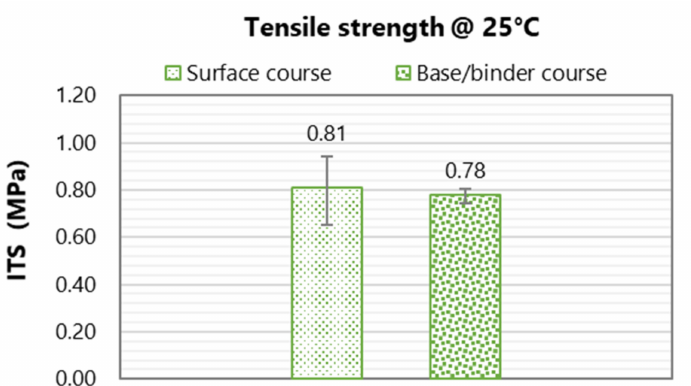
Figure 8. The indirect tensile strength of the cores after 1 year being in